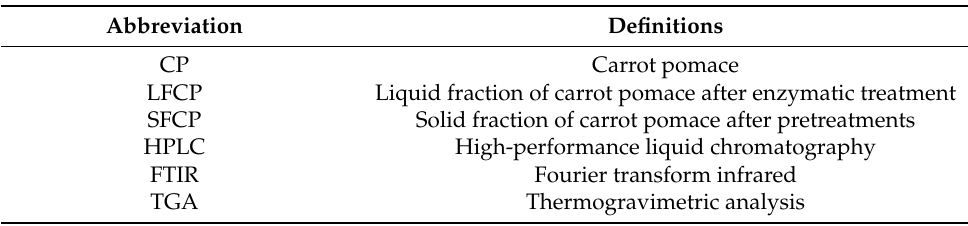
Table 1. A list of the abbreviations used in this